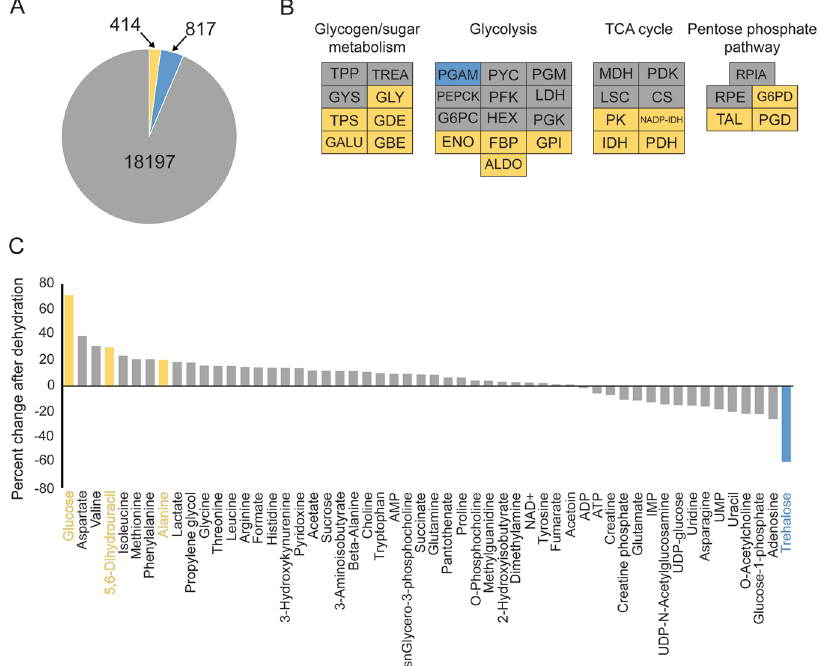
Figure 2. Dehydration enriched carbohydrate metabolism and prompted a trehalose to glucose shift for C . pipiens females. Blue denotes decreased levels during dehydration, gray indicates no difference, and yellow is increased during dehydration compared to hydrated individuals. ( A ) RNA-seq analyses following dehydration yielded differential expression of 1231 genes. ( B ) Expression levels for multiple carbohydrate-associated genes, many of which were upregulated. ( C ) Metabolomics following dehydration stress. Each value represents the average of eight replicates of combined samples with 20–30